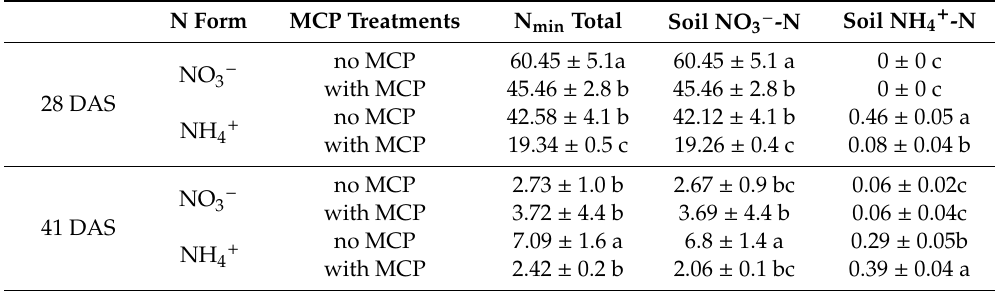
Table 5. E ff ect of MCP inoculation on total N min , NO 3 -N [mg kg − 1 soil DM] and NH 4 + − N [mg kg − 1 soil DM] after a culture period of 28 DAS and 41 DAS on a clay-loam field soil (pH 5.9) with